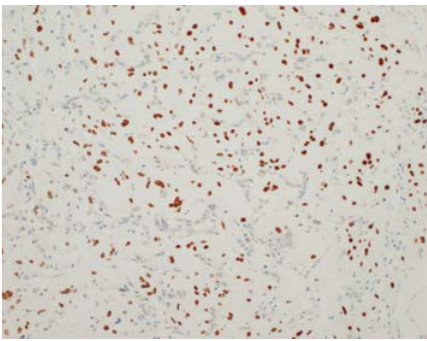
Figure 4: Transcription factor E3 (TFE3) staining on medium- powered field. The tumor showed uniform, strong nuclear positivity against the C-terminus of